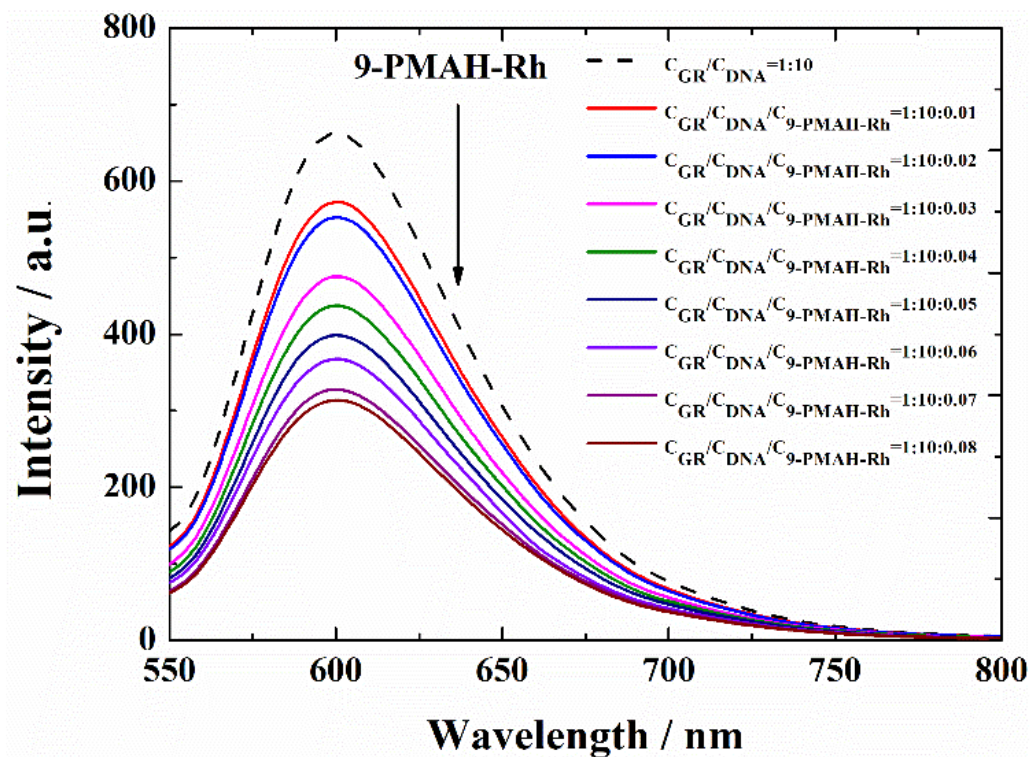
Figure 6. The intercalative binding ability of 9-PMAH-Rh to ct-DNA when competing with GelRed, examined by means of fluorescence spectral analysis.